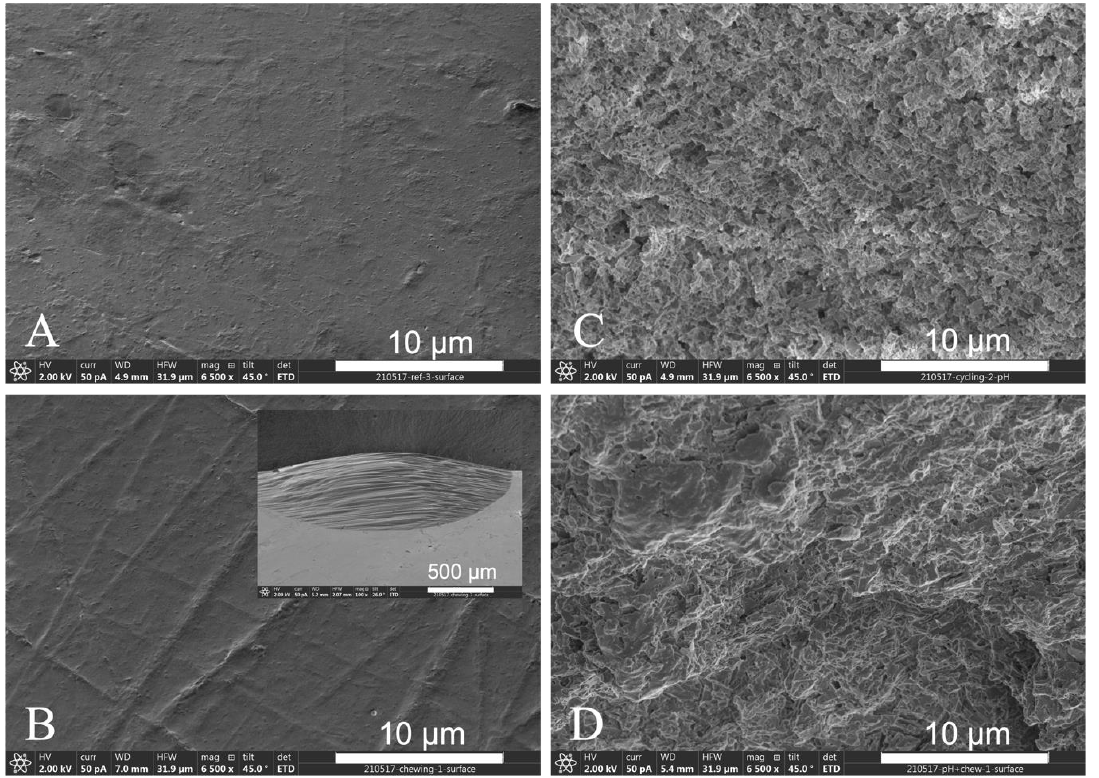
Figure 5. SEM analysis of surfaces of ( A ) reference; ( B ) chewing only (gouge on surface shown on inset); ( C ) pH cycling; ( D ) pH cycling + chewing. Line in ( A ) is 10 µ m for ( B – D ). Bar in inset is 500 µ